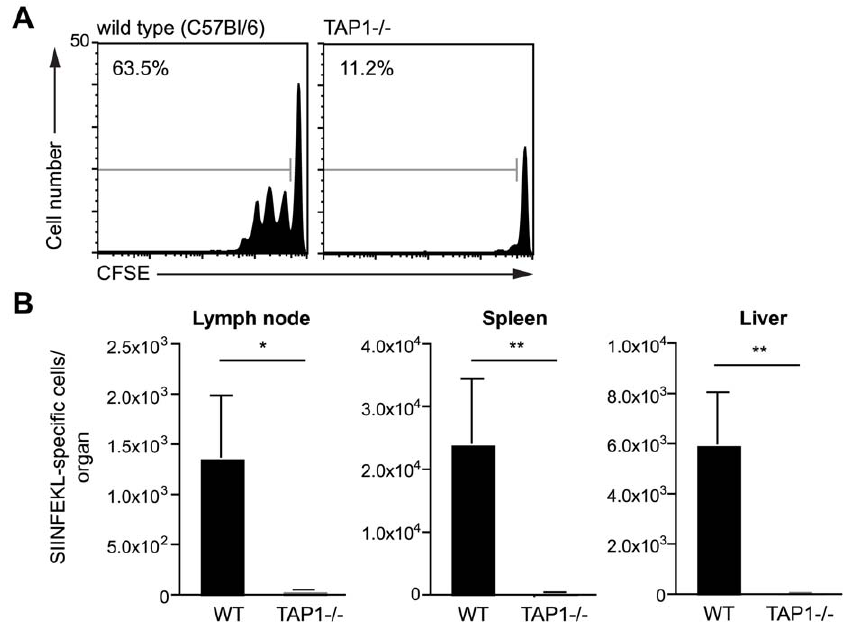
Figure 2. Antigen presentation by DCs is TAP dependent. A. CFSE profiles of SIINFEKL specific transgenic cells after incubation with dLN DCs isolated from C57Bl/6 (wild type) or TAP-1 deficient animals 2 days after immunization with 5 6 10 4 P. berghei CS 5M sporozoites/ear. Data are based on pooled DCs from 6–8 mice per group; values at top left are the percent of cells that have divided. B. TAP1-/- and C57Bl/6 (wild type) mice received 2 6 10 3 naı¨ve SIINFEKL-specific CD8 + T cells prior to being fed on by 10–20 P. berghei CS 5M infected mosquitoes. 10 days later the mice were sacrificed and the expansion of SIINFEKL-specific cells in the spleen and liver determined. Data are pooled from 2 similar experiments (mean 6 SEM; n=6).